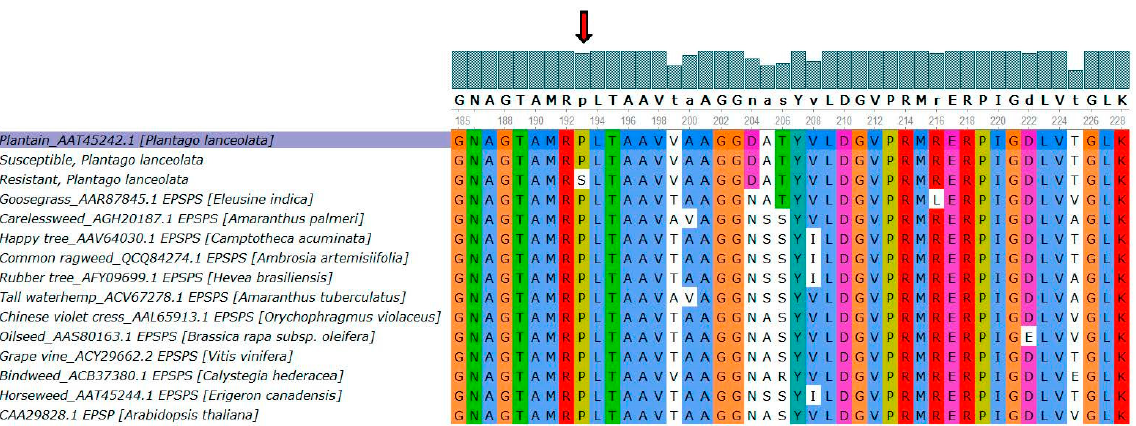
Figure 7. Figure 7. Multiple nucleotide sequence alignment of resistant and susceptible plantago ( Plantago lanceolata L.) biotypes against the EPSPS partial reference coding sequence of plantago. Two DNA variants are highlighted in the image: (1) Cytosine to Adenine transition DNA variant shown by the blue arrow and (2) Cytosine to Thymine transition DNA variant, predicted to result in a substitution of a Proline at position 106 with a Serine, denoted by the red arrow. The asterisk ( ‡ ) indicates the alternative allele and double asterisk ( ‡‡ ) indicates the reference allele.